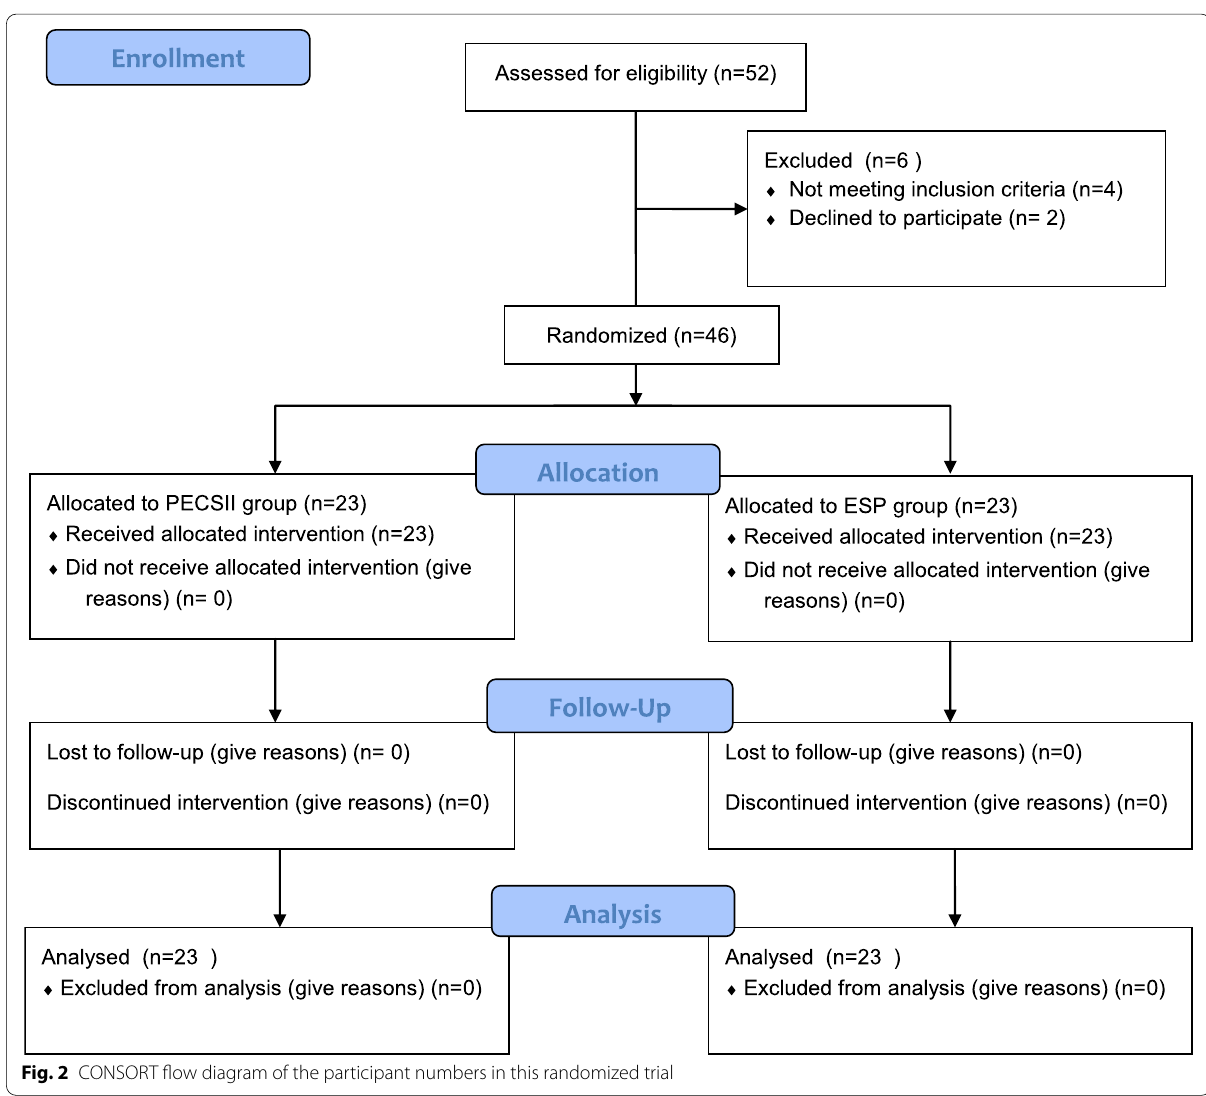
Fig. 2 CONSORT flow diagram of the participant numbers in this randomized trial